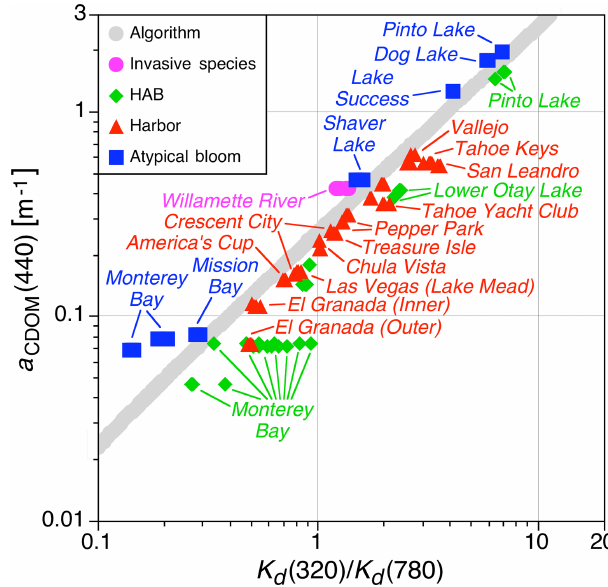
Figure 5. The new data obtained in river mouths (red circles), wa- ter bodies with known suspension or visible resuspension (green triangles), plus samples obtained closer to (magenta squares) or far- ther from (blue diamonds) the ice edge within an ice field. The San Francisco RWC channel headland waters are depicted in Fig. 3 as are the Columbia and Umpqua river data that are upstream of the river mouth.